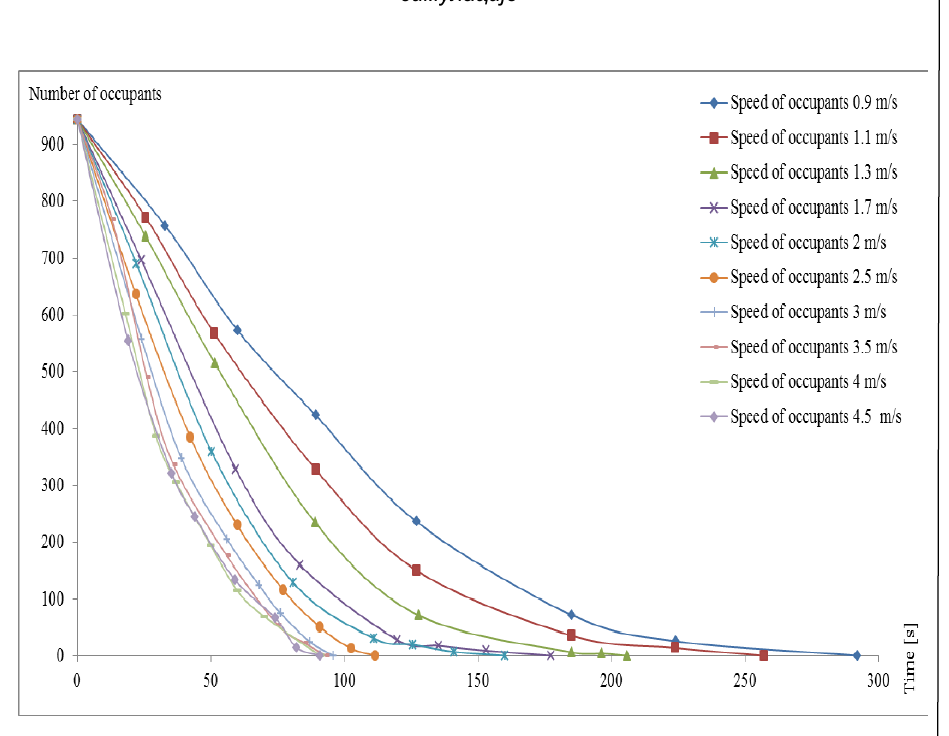
Figure 9 – Complete simulation results for the first